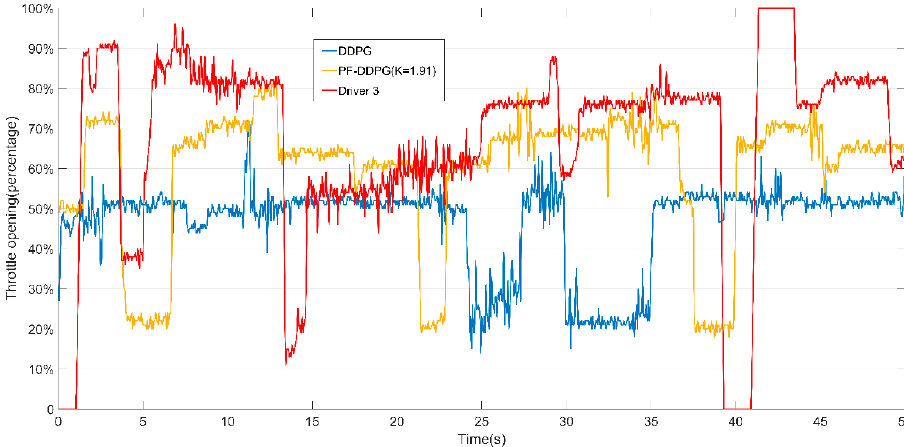
Figure 7. Throttle comparison of PF-DDPG, DDPG and Driver 3.